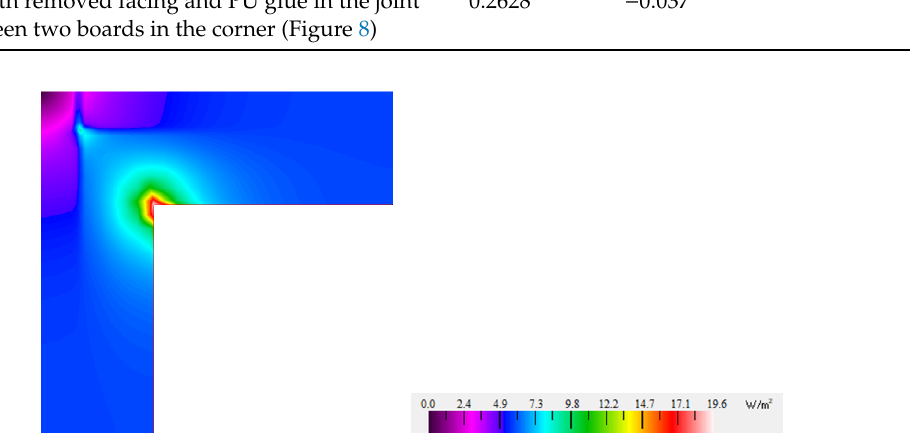
Figure 5. The heat flow rate through the wall corner insulated with PIR without facing.